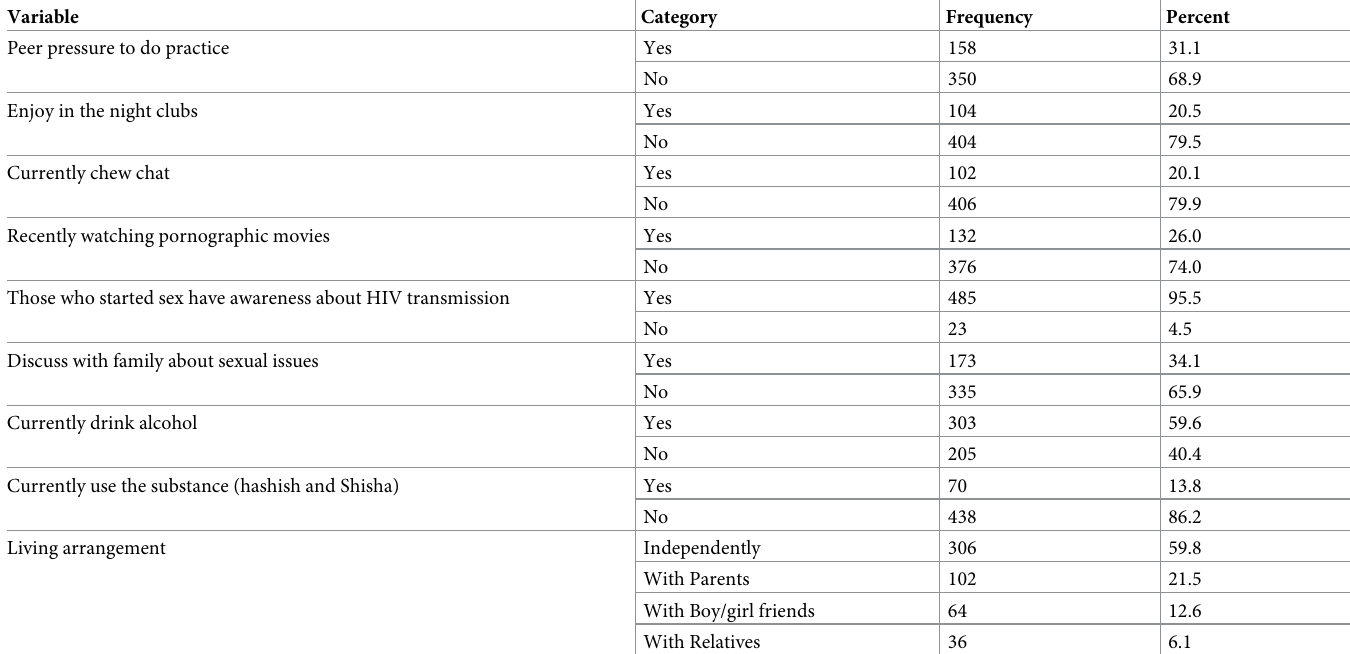
Table 3. Behavioral characteristics of big construction site daily laborers, Bahir Dar in city.